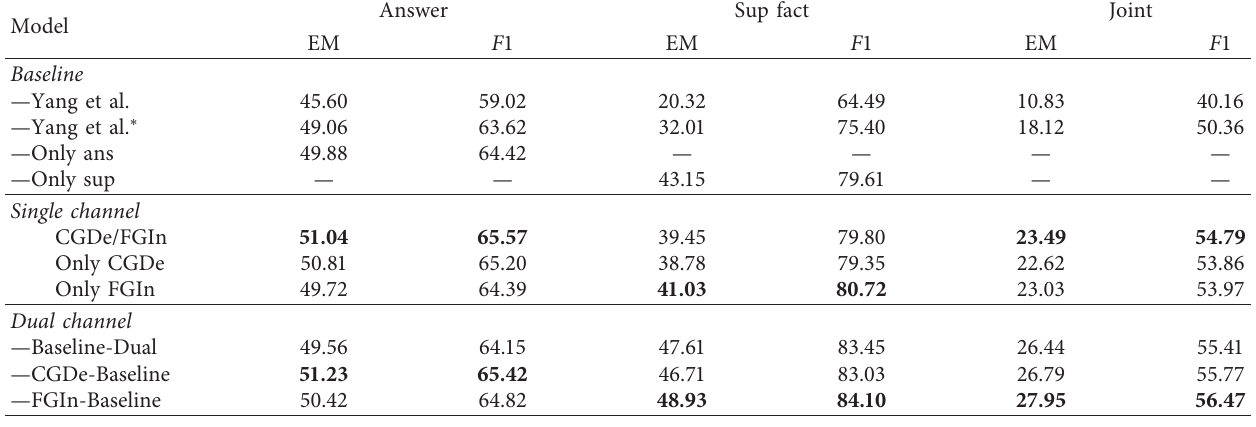
Table 2: Ablation results on the HotpotQA